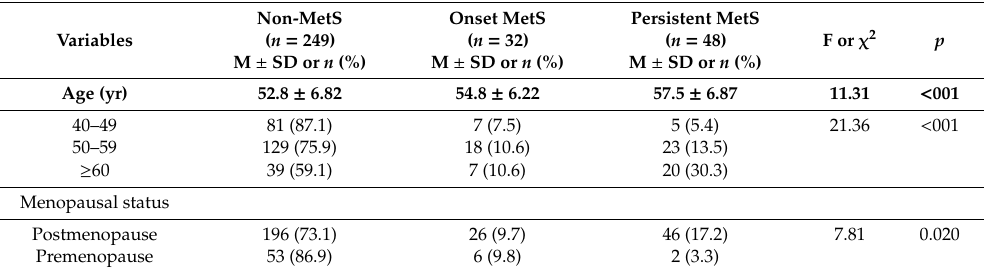
Table 1. Sociodemographic characteristics among breast cancer